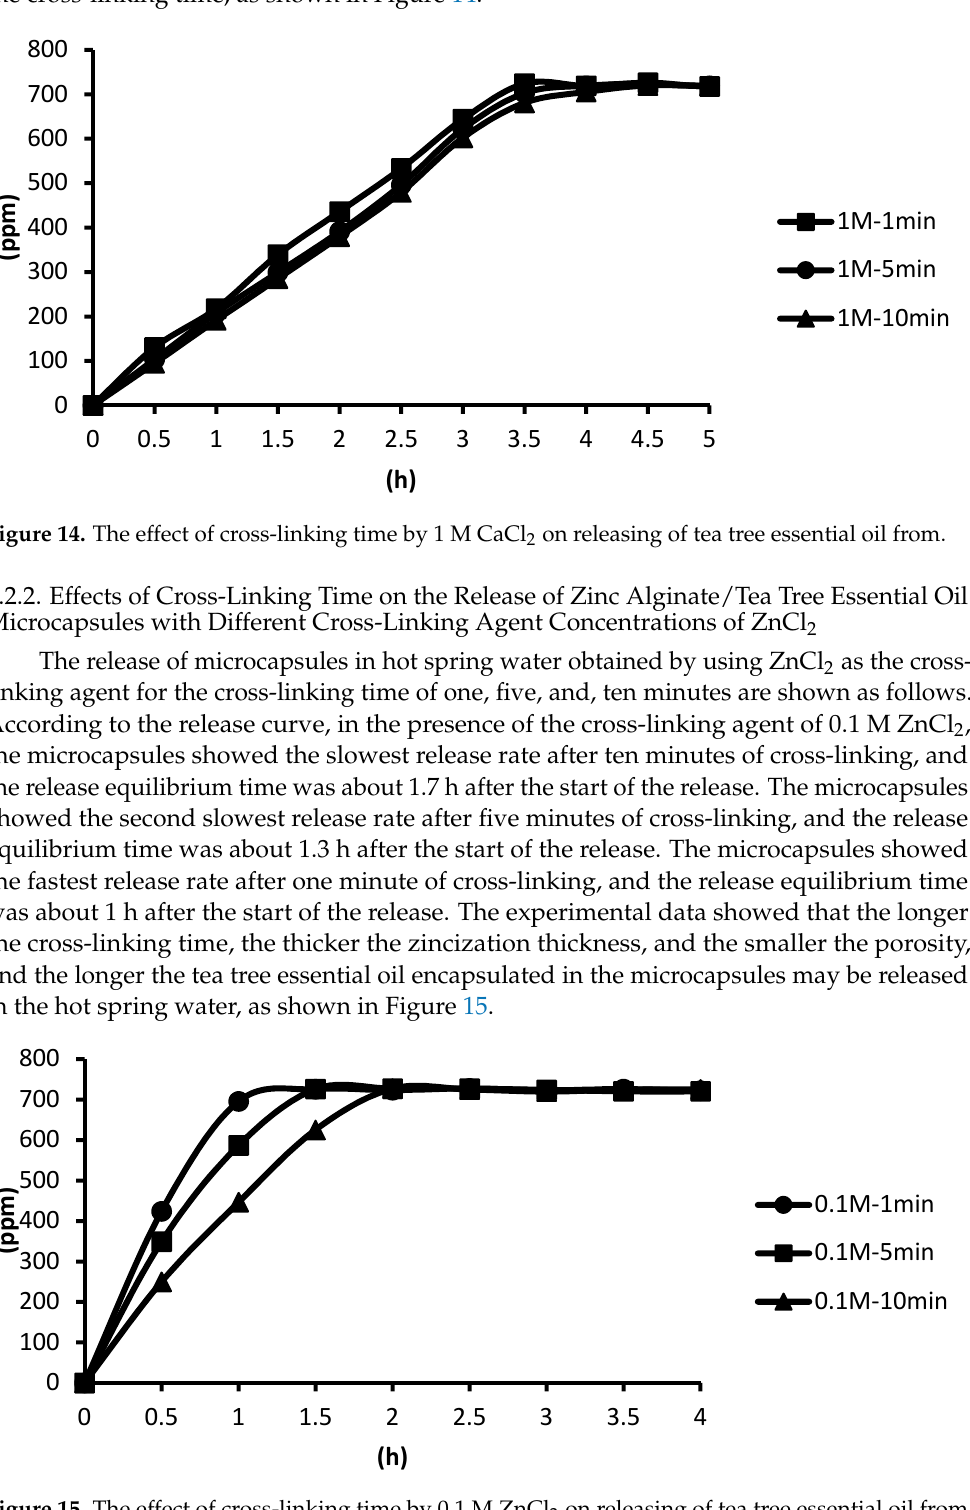
Figure 15. The effect of cross-linking time by 0.1 M ZnCl 2 on releasing of tea tree essential oil from alginate/tea tree essential oil microcapsules in the hot spring water.